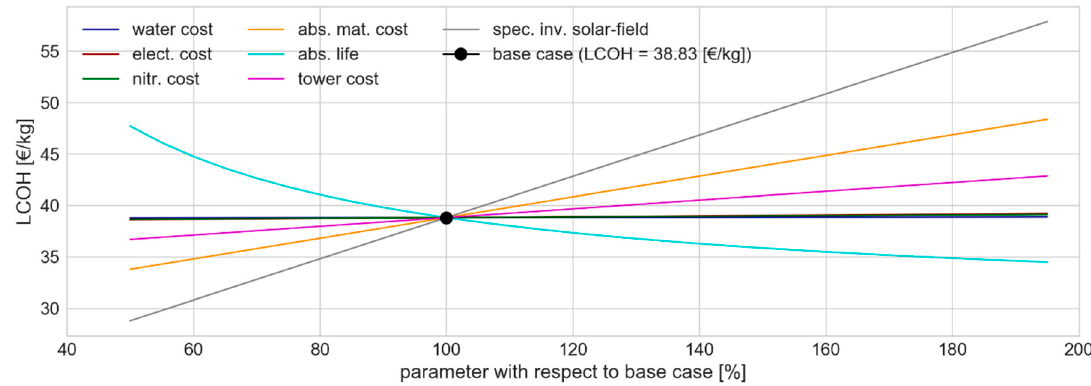
14 of 17 Table A2. Structure of the heliostat field efficiency matrix, as a function of solar elevation angle (vertical axis) and solar azimuth angle (horizontal axis) – example for intercept power 11.5 MWth and latitude 20° N. Azimuth  Sun height ↓ 0.7695 Table A3. List of ranges used for the economic parametric study. Parameter